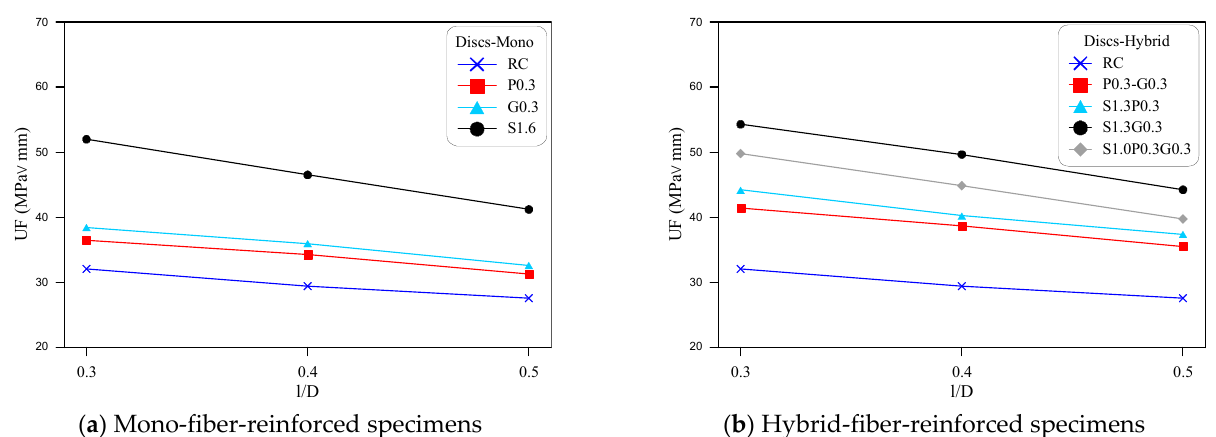
Figure 4. Mode II disc specimens’ fracture energy for different notch depth-specimen diameter (l/D) ratios.